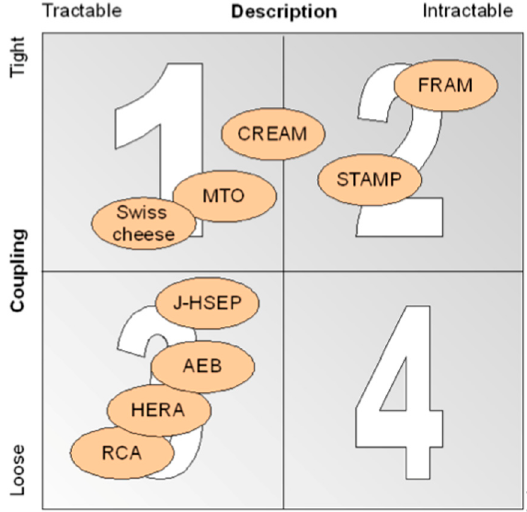
Figure 3. Characterization of accident methods (with permission from Erik Hollnagel).